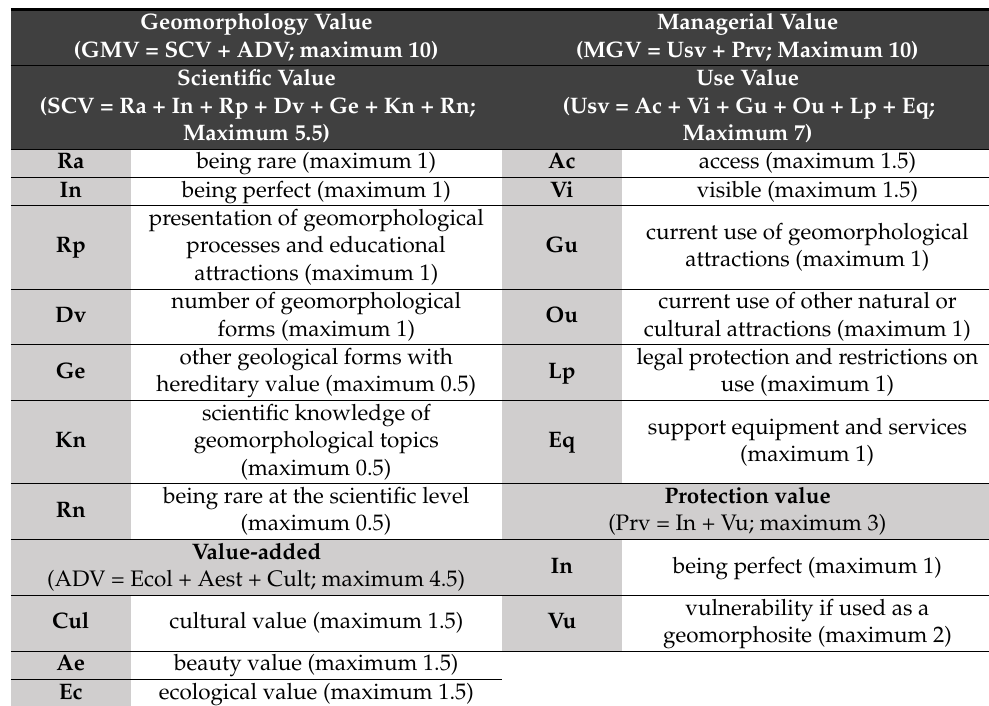
Table 3. Evaluation of the four geomorphotourism criteria based on the Pereira method.